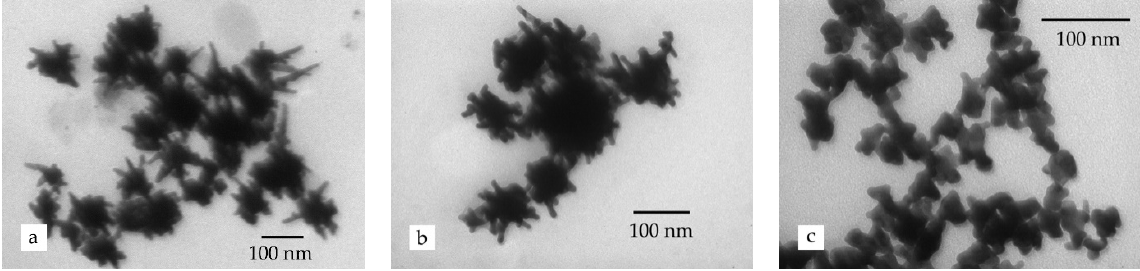
Figure 8. TEM images of GNS prepared in different amplitudes—( a ) 60 µm, ( b ) 80 µm and ( c ) 100 µm. Table 7. The influence of amplitude to surface plasmon resonance and intensity absorbance.